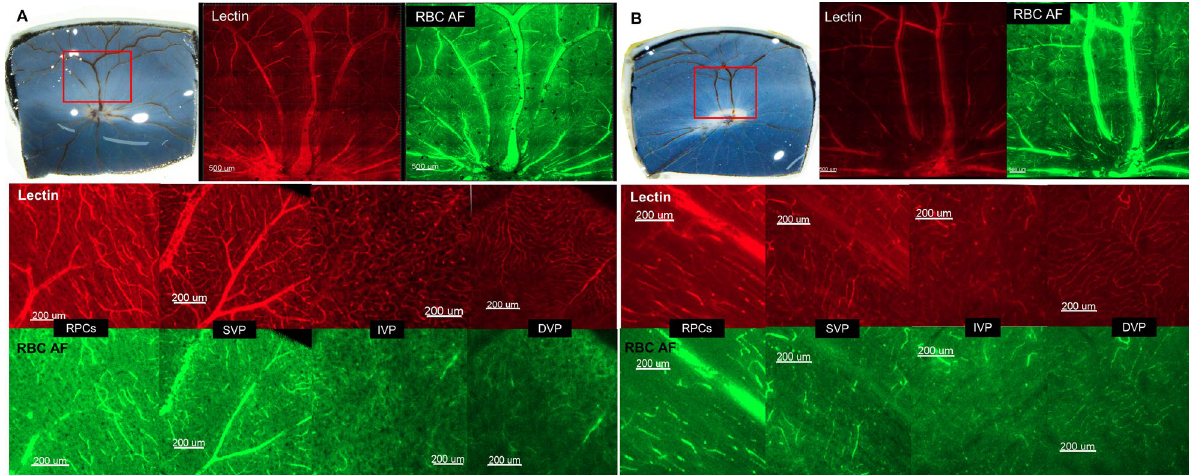
Figure 5. Tissue staining of retinal capillary layers at baseline ( A ) and 90 mmHg of IOP ( B ). The tissue area examined by OCTA was confirmed in gross specimens (upper left) and then lectin staining was performed. The entire tissue was divided into 25 tiles and orthogonal confocal images (× 5 magnification) of the lectin stain (upper middle) and RBC autofluorescence (upper right) were obtained. (second and third rows) En face view of the different capillary levels of the pig retina (upper: lectin-stained images, lower: RBC autofluorescence images).